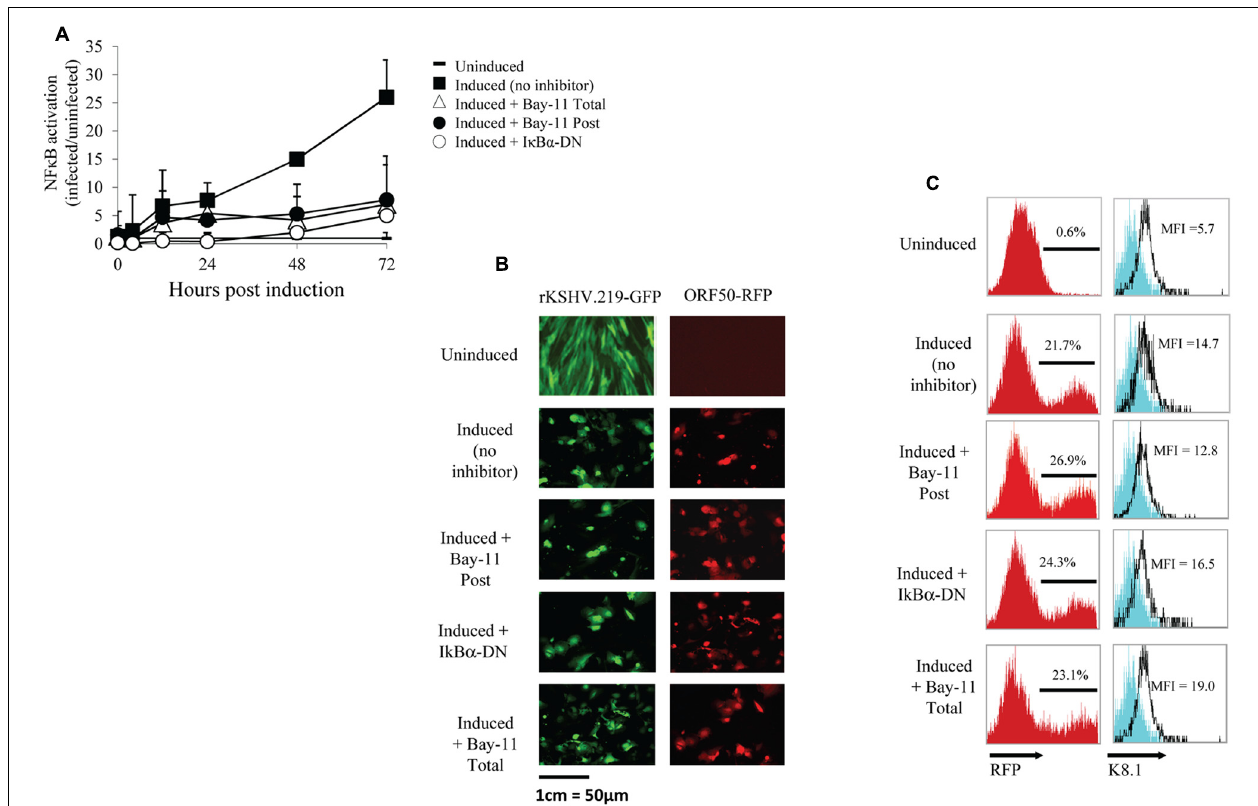
FIGURE 2 | NF κ B inhibition does not affect viral reactivation. (A–C) HF cells either mock infected or infected with rKSHV.219, transfected with pBXII-Luc and then induced to undergo lytic replication, except for the Uninduced sample. When indicated, cells were either mock treated (No inhibitor), cotransfected with I κ B α -DN or treated with Bay11-7082 prior to induction (Total) or at time of induction (Post). (A) Cell lysates were harvested; luciferase values reflect NF κ B activation as the fold-increase of infected/uninfected samples (set to 1); mean ± SD from triplicate transfections in one experiment, representative of three independent experiments. Student’s t -test was used for statistical